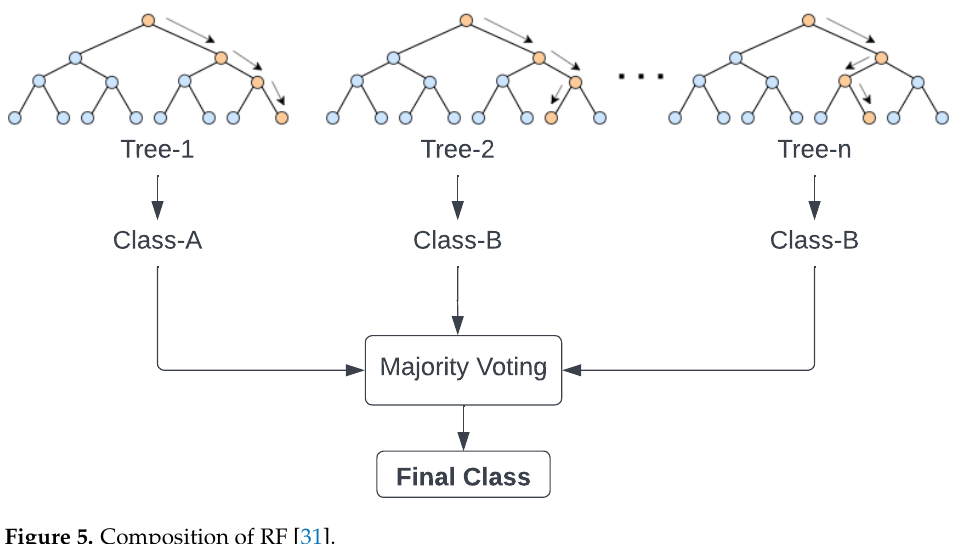
Figure 5. Composition of RF